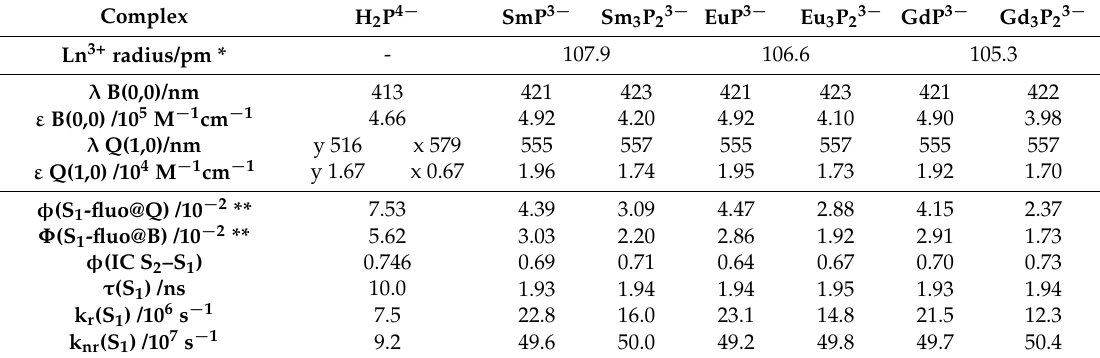
Table 2. Characteristic photophysical data of the investigated lanthanide(III) mono- and bisporphyrins.